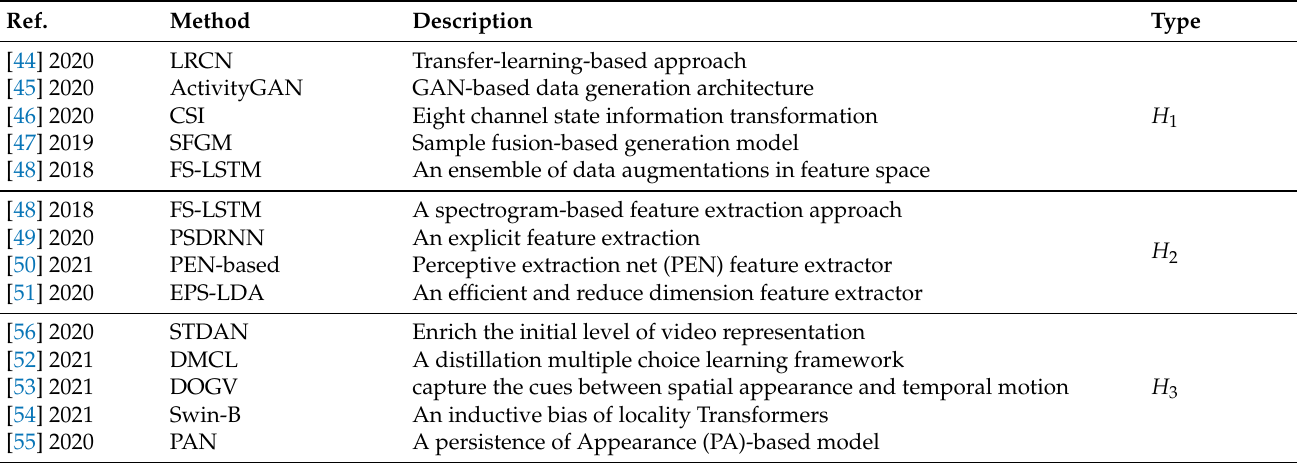
Table 2. Related work on